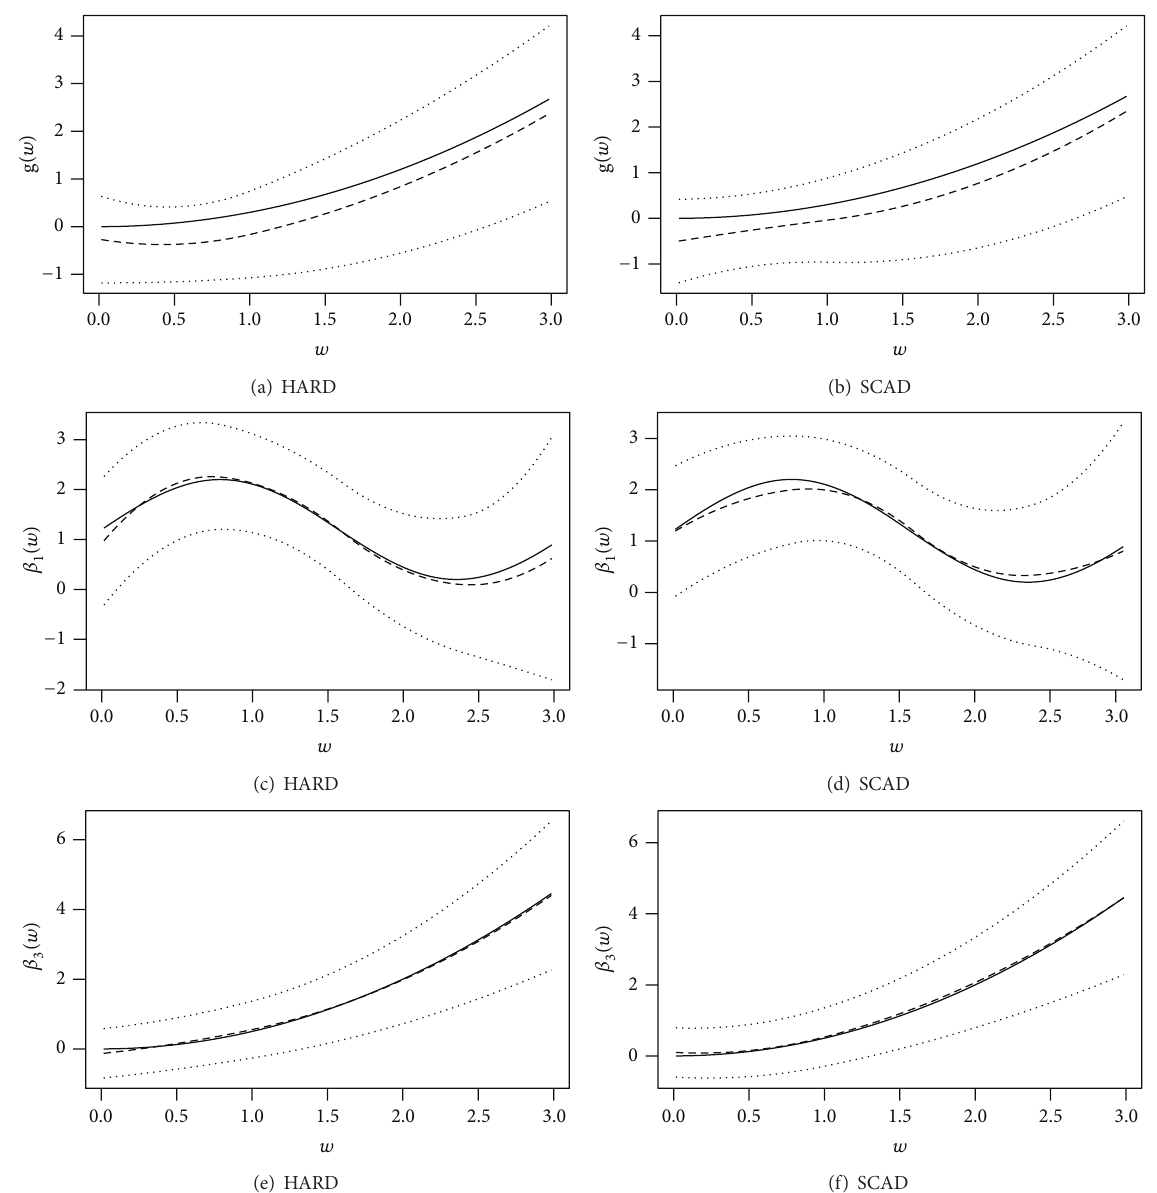
Figure 2: Results of the simulation study for scenario (II). The legend is the same as in Figure